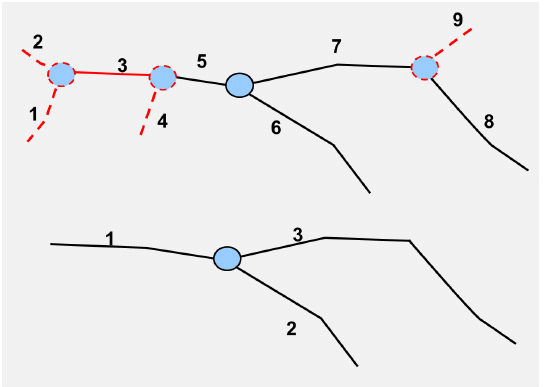
Figure 2: Filtering polylines. Top: assessing segments and junc- tions, bottom: updating topology. See text for more